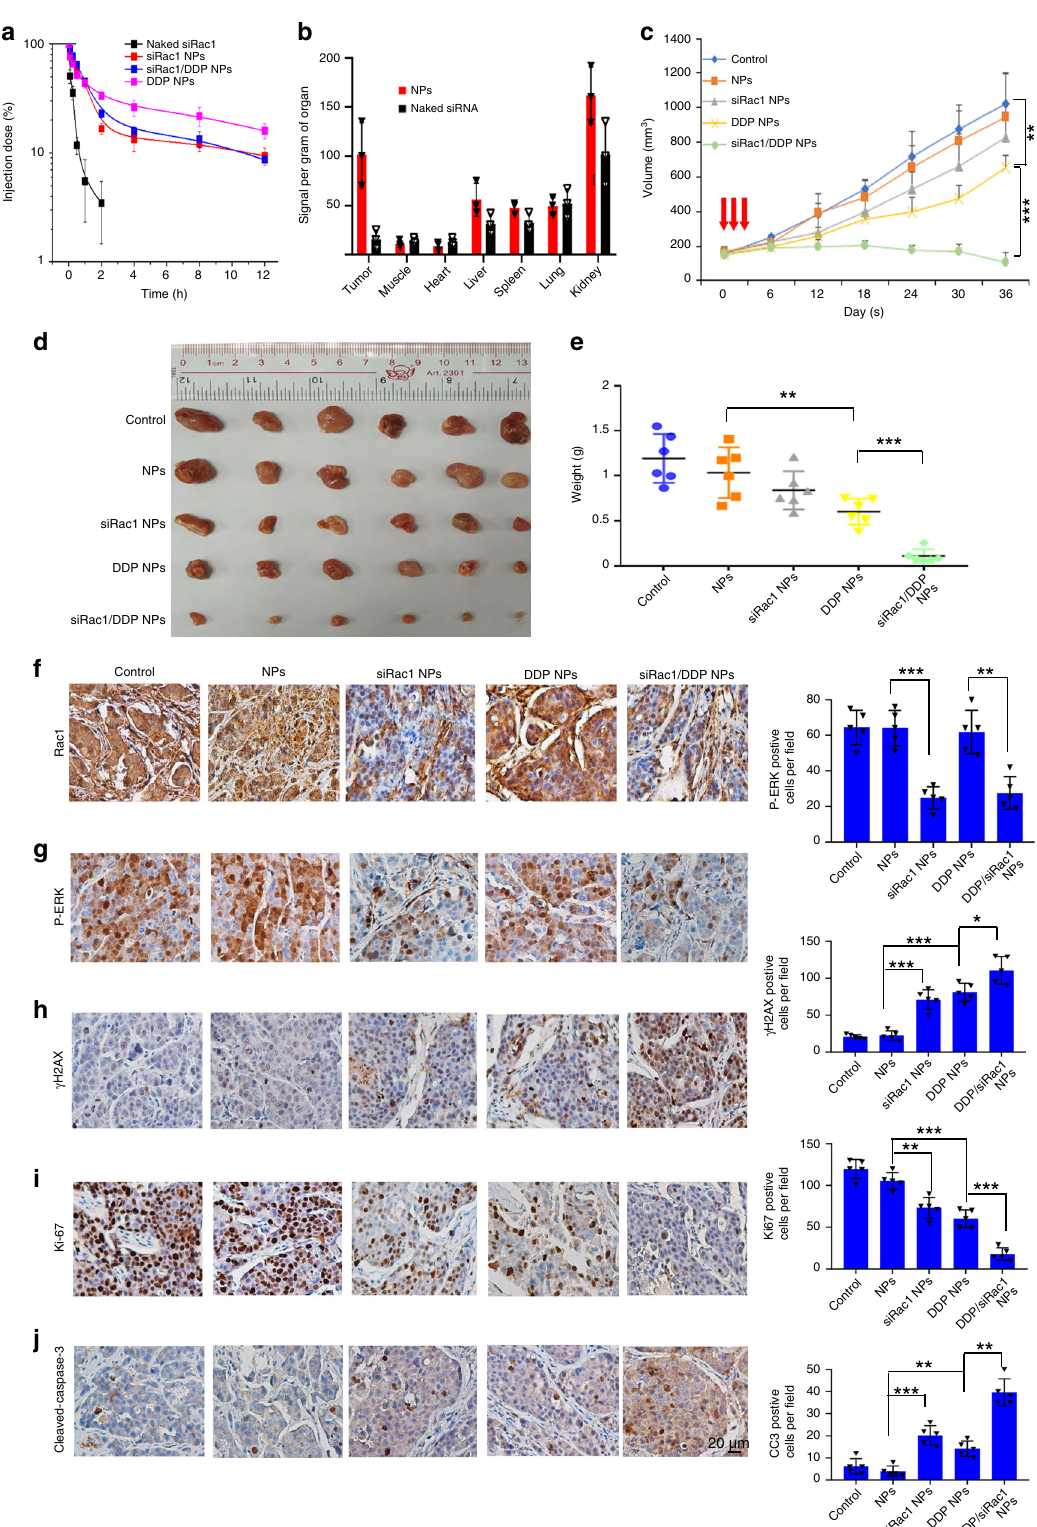
Methods 7 – 37 months (median follow-up are 61 months and 43 months). Among the 198 Patients and tissue samples . Breast cancer samples were obtained from Breast tumor samples, there are 84 corresponding adjacent normal tissues. Pathological diagnosis, as well as ER, PR, and HER2 status, were veri fi ed by two pathologists Tumor Center, Sun Yat-Sen Memorial Hospital, Sun Yat-Sen University. In all, independently. All human samples were collected with informed consents from 198 surgical resected tumors and 133 core needle biopsies of breast cancer before the donors according to the International Ethical Guidelines for Biomedical neoadjuvant chemotherapy were collected from January 2010 to June 2013 and Research Involving Human Subjects (CIOMS). The study was performed after 2014 to 2017, respectively. The patients were followed up for 1 – 109 months and NATURE COMMUNICATIONS| (2020) 11:1456